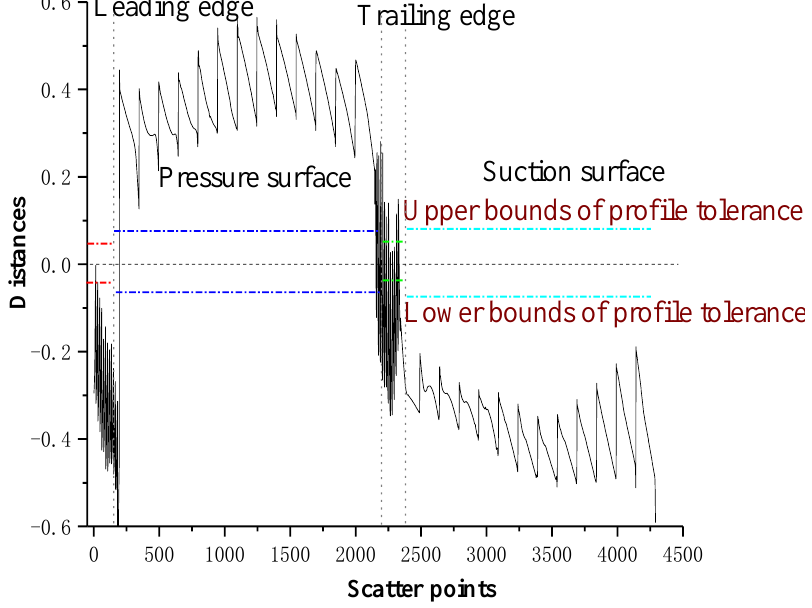
Figure 12. The distances from the profile curves to the tolerance bands with unconstrained optimi- zation.